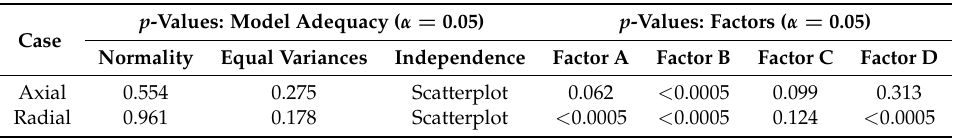
Table 3. Model adequacy and ANOVA